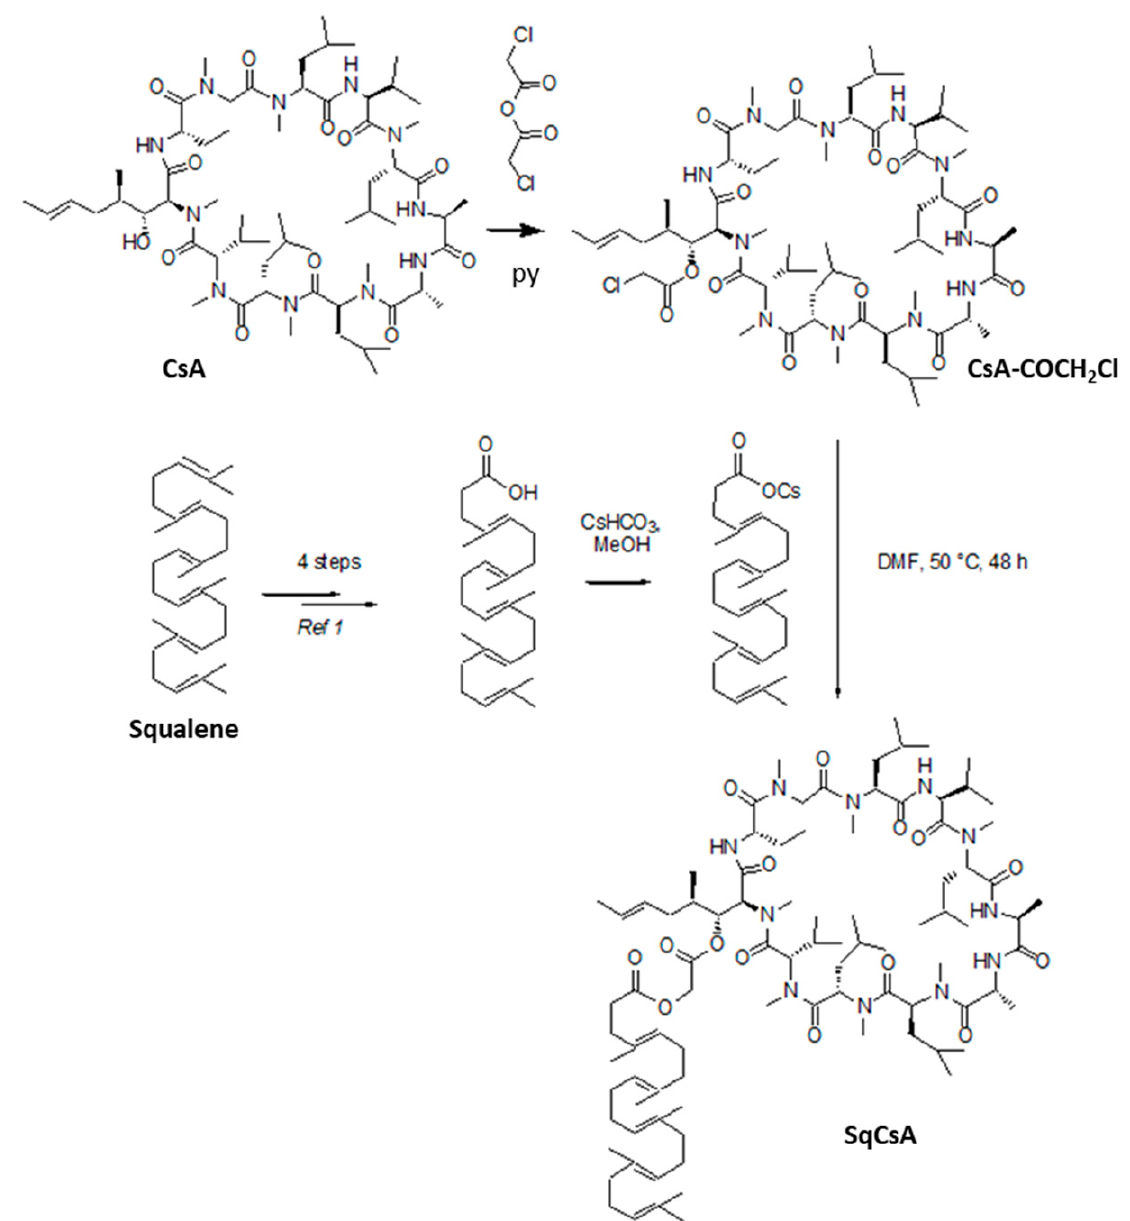
Figure 1. Synthetic scheme of the squalene cyclosporin A (SqCsA) conjugate. The squalene chain was introduced on the side chain of the MeBmt residue through a glycolate linker by chloroacetylation of the CsA followed by S N 2 displacement of the chloride using squalenic acid cesium